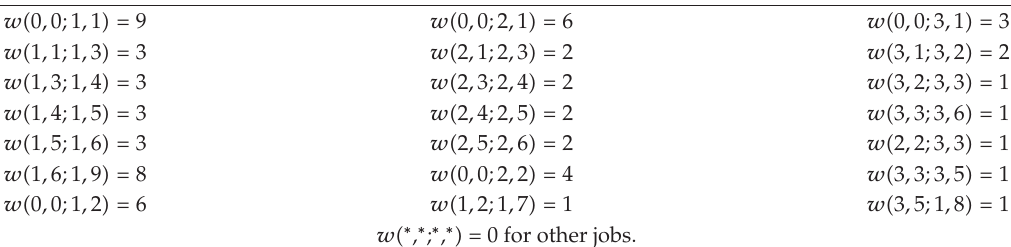
Table 2: The setup time of